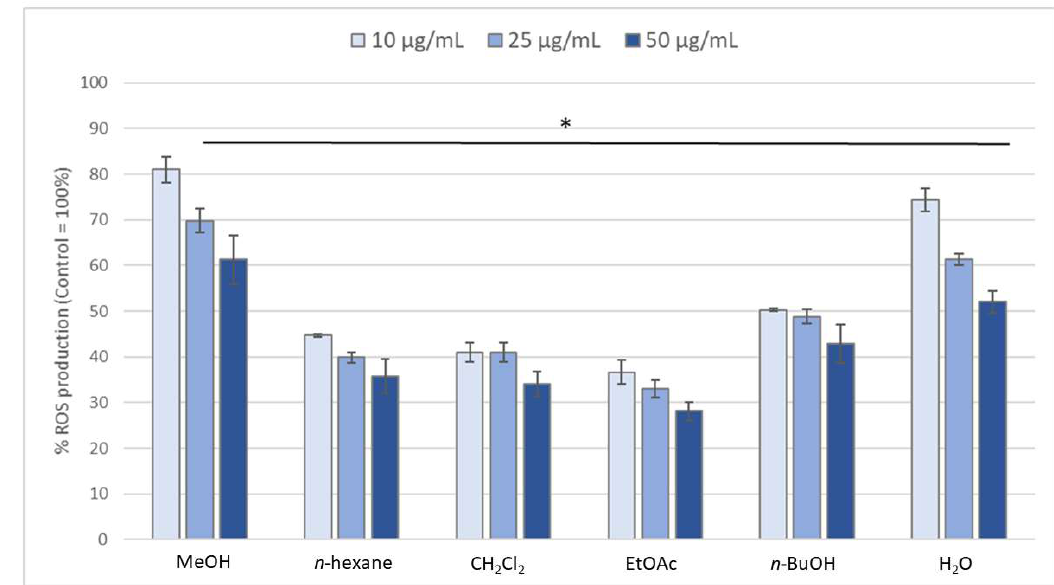
Figure 1. ROS production of blood leucocytes, incubated with the methanolic extract or fractions (10, 25 and 50 µg/mL) and stimulated with PMA (1 µM) for 1 h. Values are expressed as percentage of the control (cells incubated with PMA and without extract). Data are shown as means ± SEM (n = 3–6); * p < 0.05 compared with Control. All results are expressed as a percentage, with control ( i.e. cells with PMA but without extract) normalized as 100%.